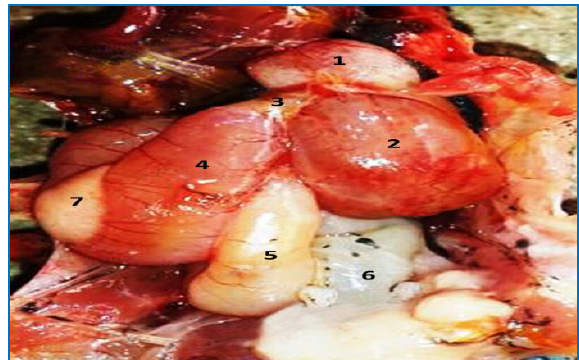
Figure, 4: parts of small intestine in white eared bulbul (1) proventriculus, (2) gizzard, (3) ventriculo-duodenal junction, (4) duodenum, (5) jejunum, (6) ileum, (7)